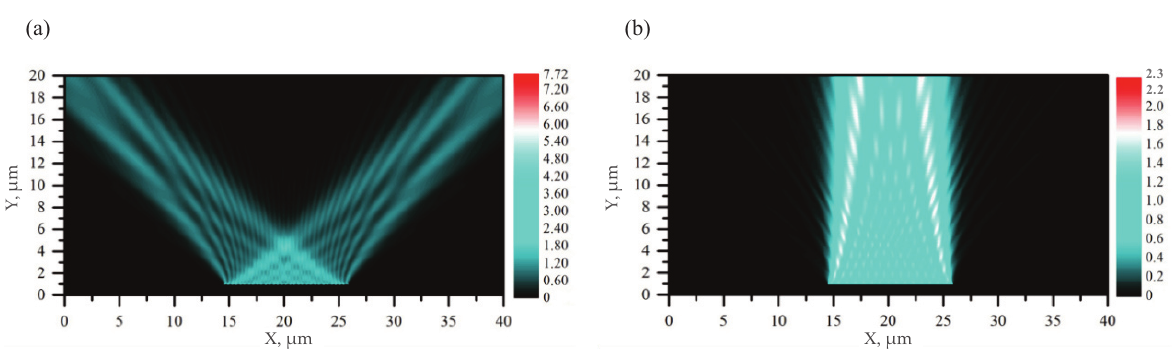
Fig. 4. Light distribution of the secondary light source 1 and the secondary light source 2 corresponding to h = 129 nm (a) and h = 257 nm